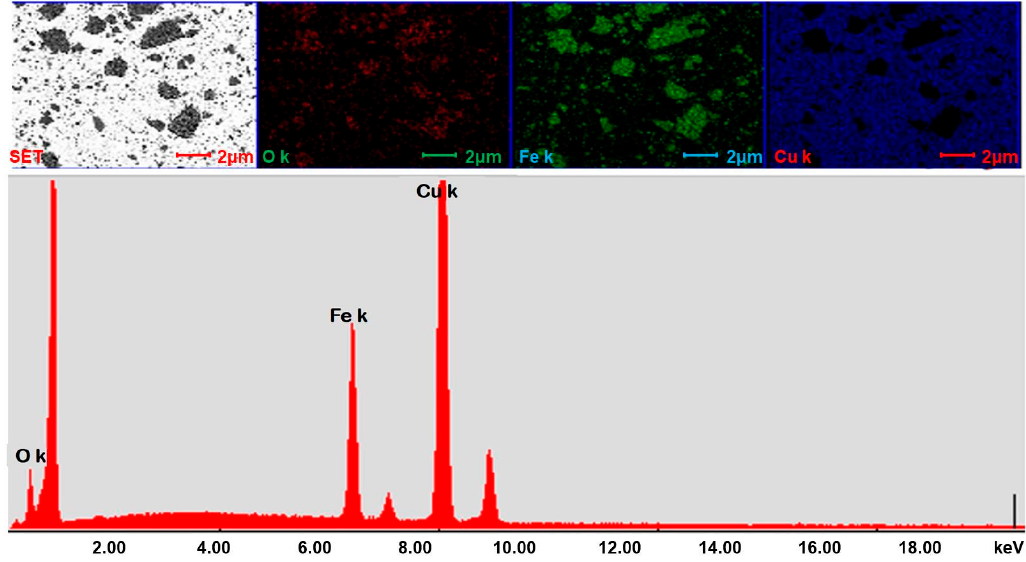
Figure 9. SEM images and EDS spectra recorded for a Cu-Fe 3 O 4 composite.